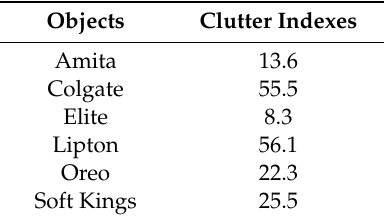
Table 6. Detection rates of methods on the Doumanoglou dataset (%).